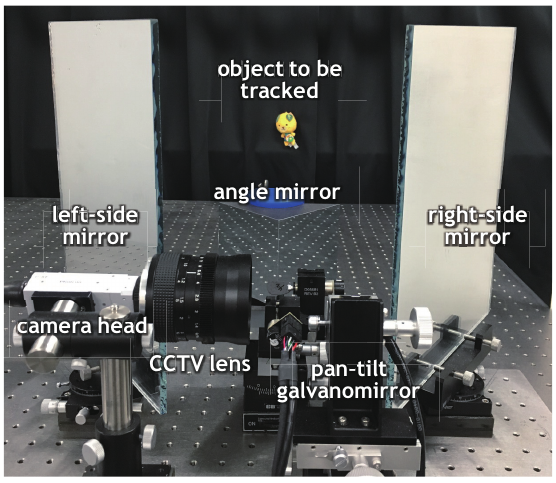
Figure 6. Overview of catadioptric stereo tracking